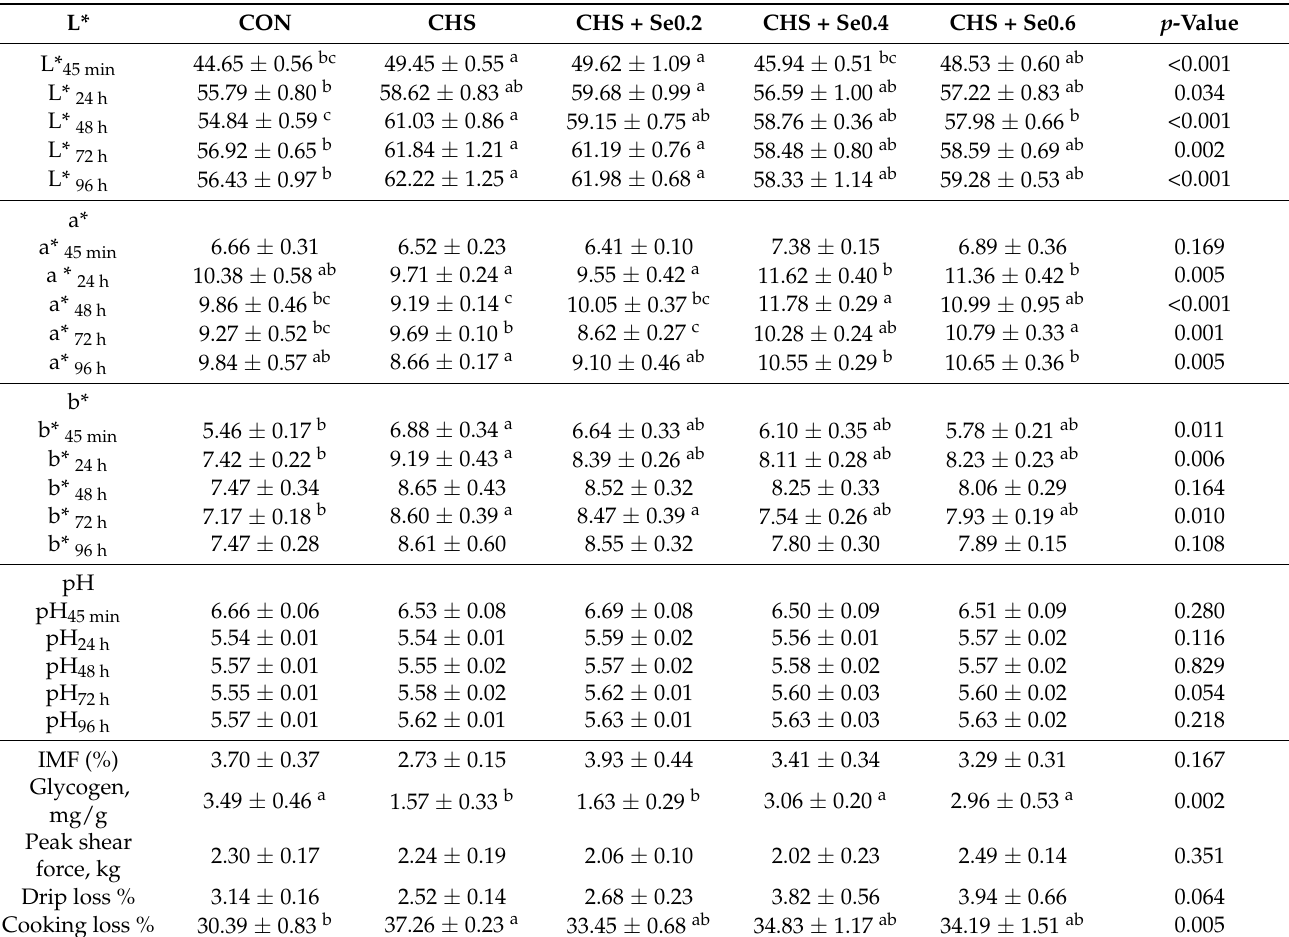
Table 4. Effects of CHS and OH-SeMet supplementation on meat quality of pigs.